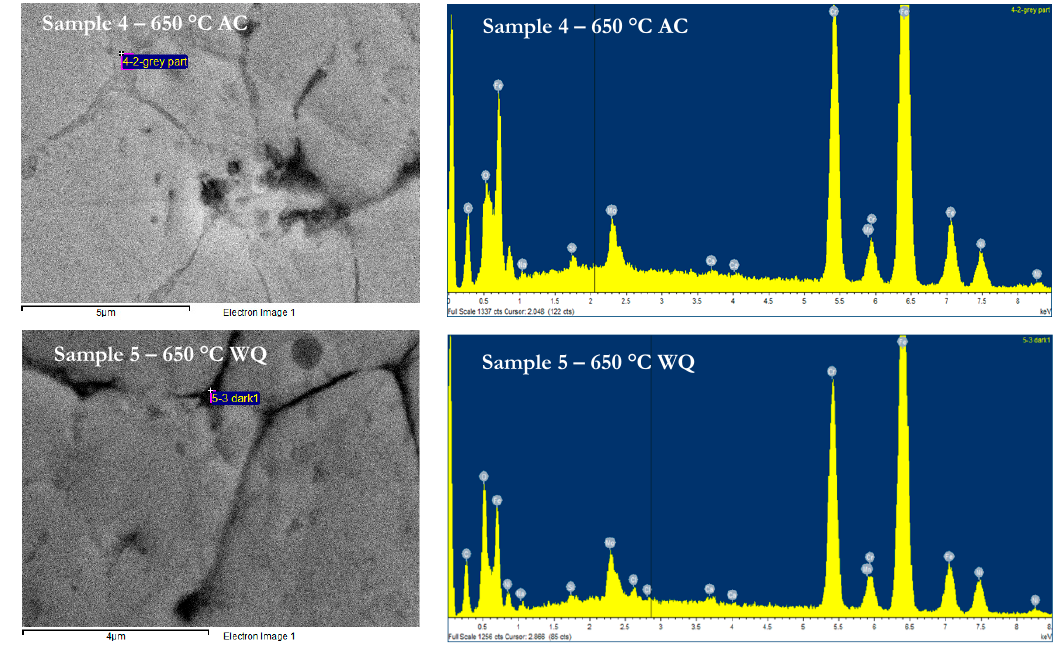
Figure 3. The precipitation behaviors of sigma phase in the temperature of 650 °C.